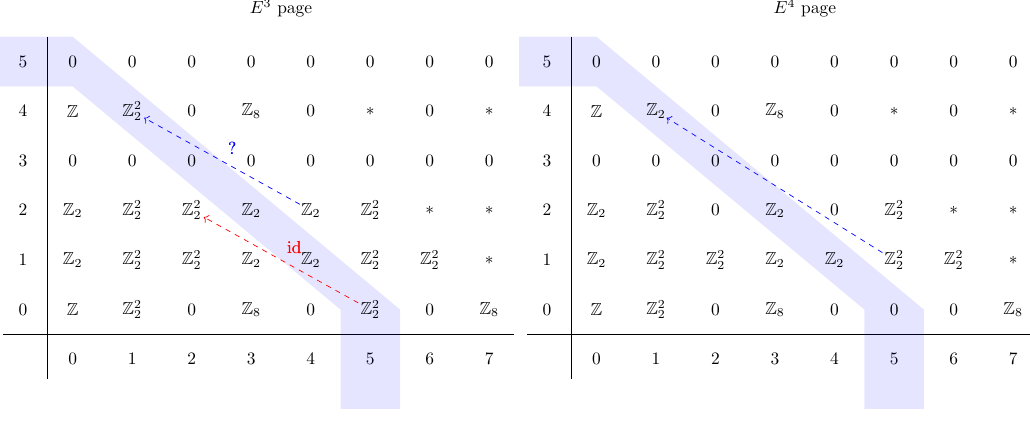
Figure 8. The E 3 and E 4 pages of the AHSS for Ω Spin • ( BQ 8 )